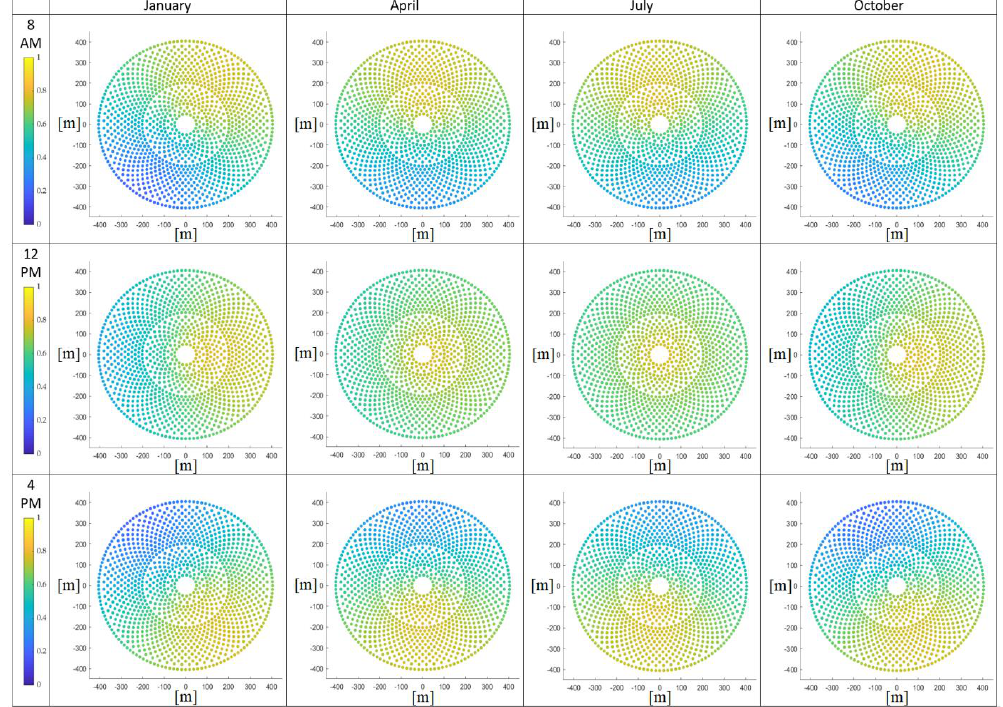
Figure 4. Contours of the monthly averaged optical efficiency of the heliostat field for the months of March, June, September and December, at 8 a.m., 12 p.m. and 4 p.m.